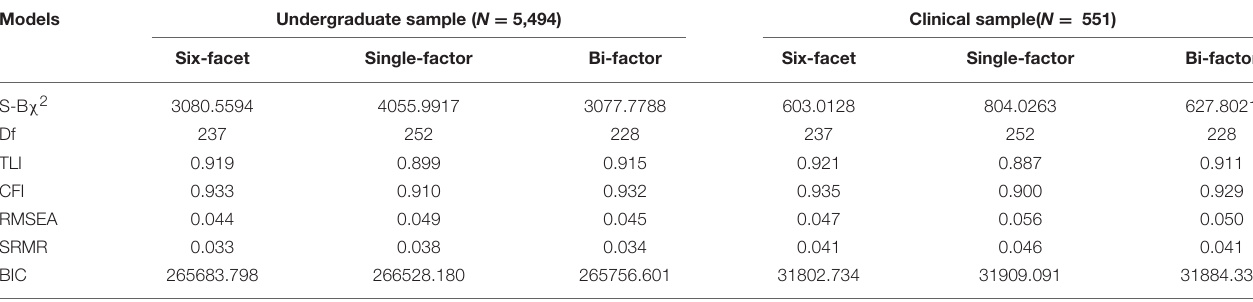
TABLE 1 | The model fit indices of the six-facet model, the single-factor model and the six-facet bi-factor model in the two groups.